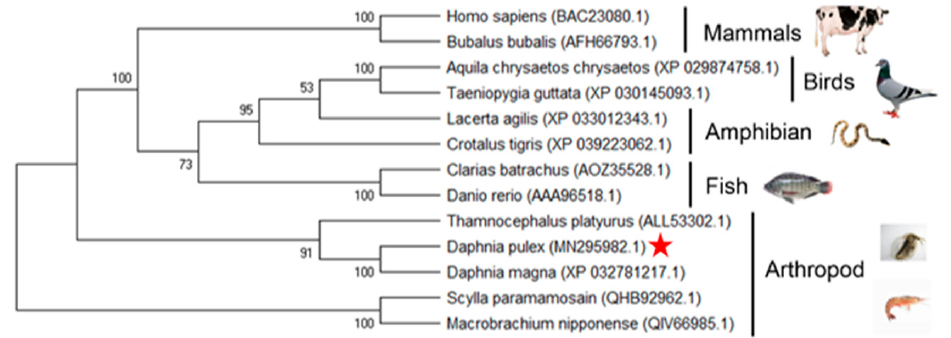
Figure 5. Phylogenetic tree of the Wnt4 clans from multiple species. Phylogenetic trees were constructed by the neighbour-joining (NJ) method using MEGA 5.0 software [30]. Red pentagram: it is Daphnia pluex (MN295982.1).